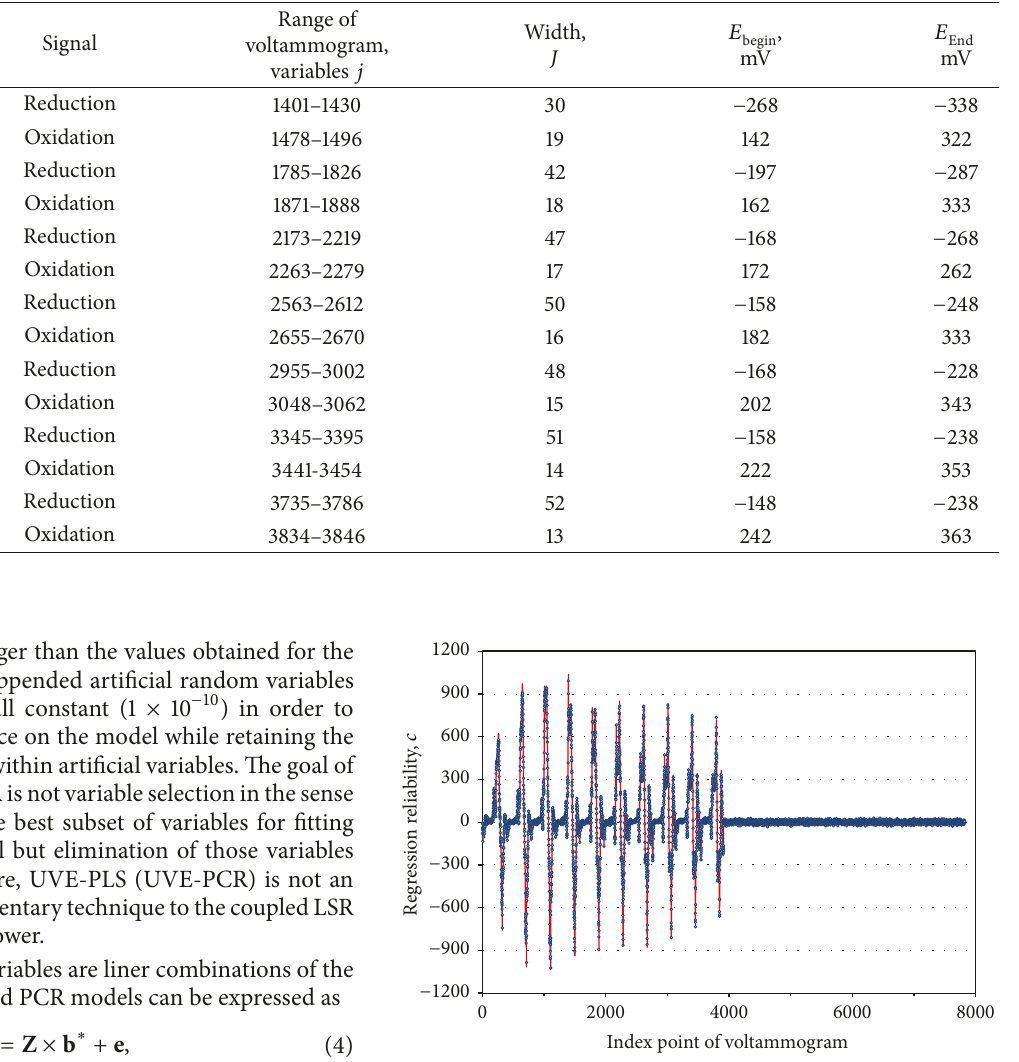
Figure 4: Regression reliability, 𝑐 (see (7)), calculated by UVE-PLS (blue diamonds) and UVE-PCR (red solid line) (both for 𝐹 = 1 ) for 𝐽 = 3911 points of mean centered voltammogram augmented by 𝐽 artificial random